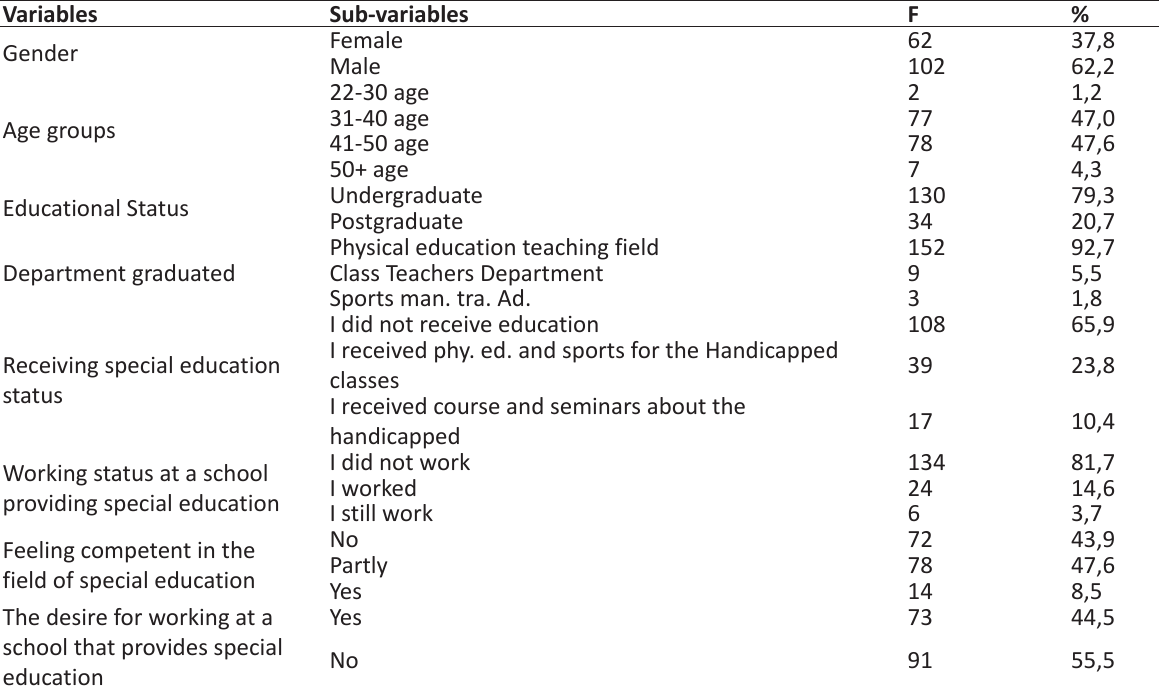
Table 1. Frequency Distributions on the Demographical Data of the Participants Variables